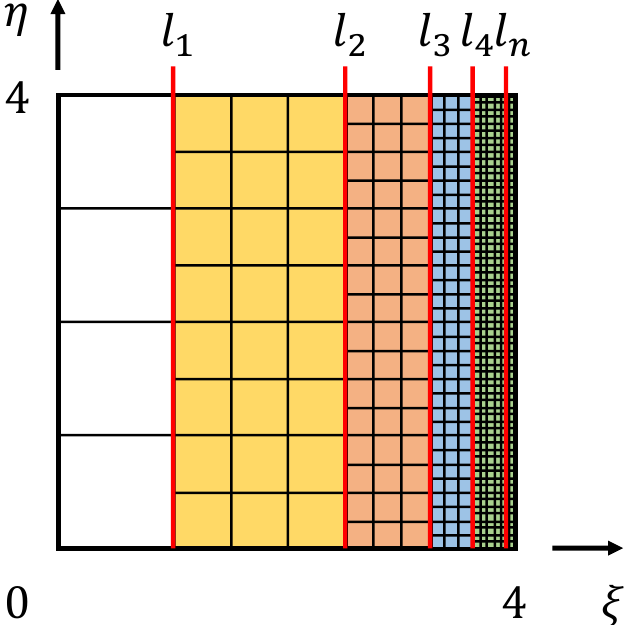
Figure 10. n -stripe refinement on a 4 × 4 domain. The left boundary of each refinement region Ω i is provided by ξ = 4 − 3 · 2 1 − i and the right boundaries coincide at ξ = 4. The splitting lines during kd-tree subdivision are labeled with l i , i = 1,2, · · · , n